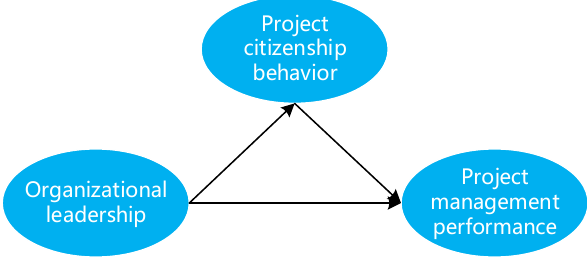
Figure 1. Hypothesized theoretical model of OL, PCB, and PMP.